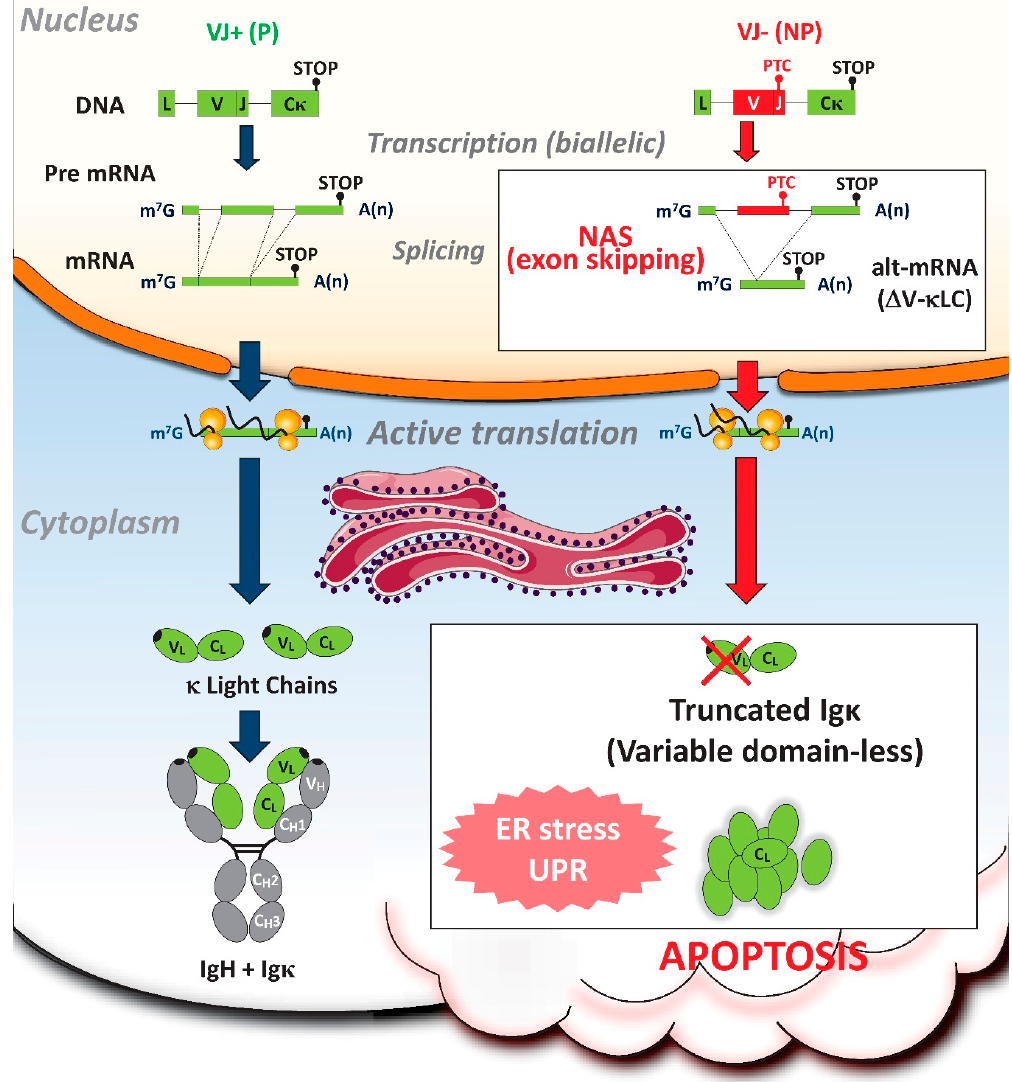
Figure 3. Consequences of NAS on Ig κ transcripts in antibody-secreting plasma cells. Because most B-lineage cells harbor nonproductive (NP) Ig gene rearrangements [82,83], the boost of Ig gene transcription accompanying their plasma cell (PC) differentiation generates considerable amounts of nonsense Ig transcripts. In PCs with biallelic (VJ +/ VJ − ) Ig κ rearrangements, the presence of premature termination codons (PTCs) activates NAS with skipping of the variable (V) exon. Remarkably, alternative V-less κ light chain ( ∆ V- κ LC) mRNAs encode truncated Ig chains (lacking V-domain) which induce PC apoptosis through exacerbated ER stress and unfolded protein response (UPR) [106]. By eliminating numerous PC clones with biallelic Ig κ rearrangements, in an antigen-independent